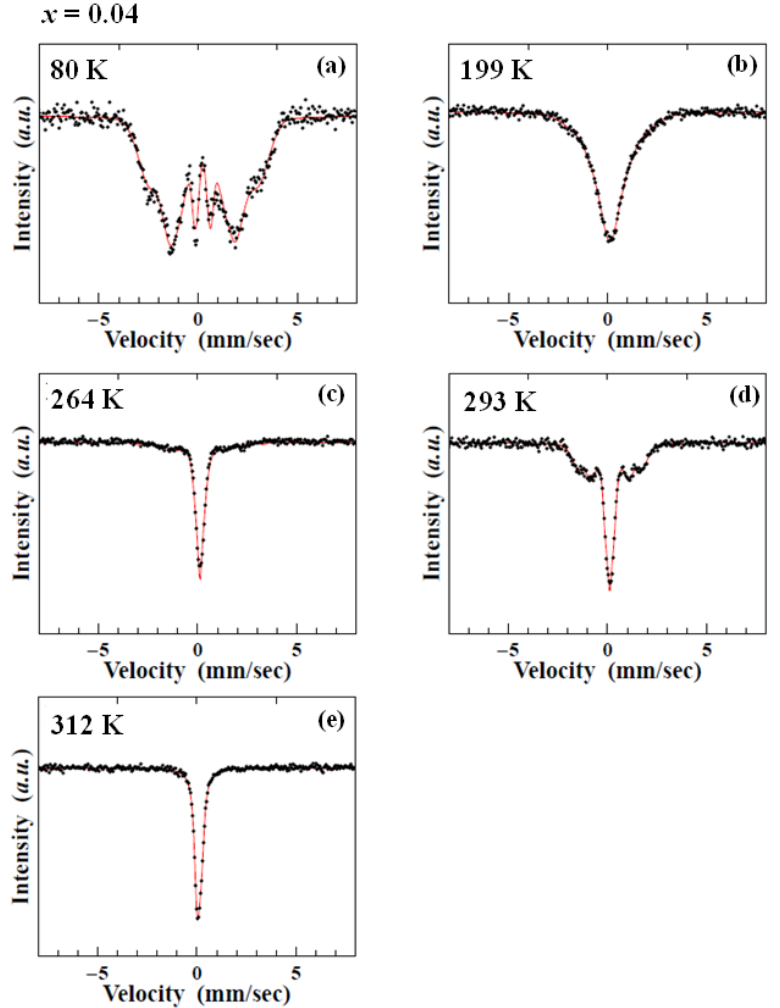
Figure 4. 57 Fe Mössbauer spectra and their fitting curves for x =